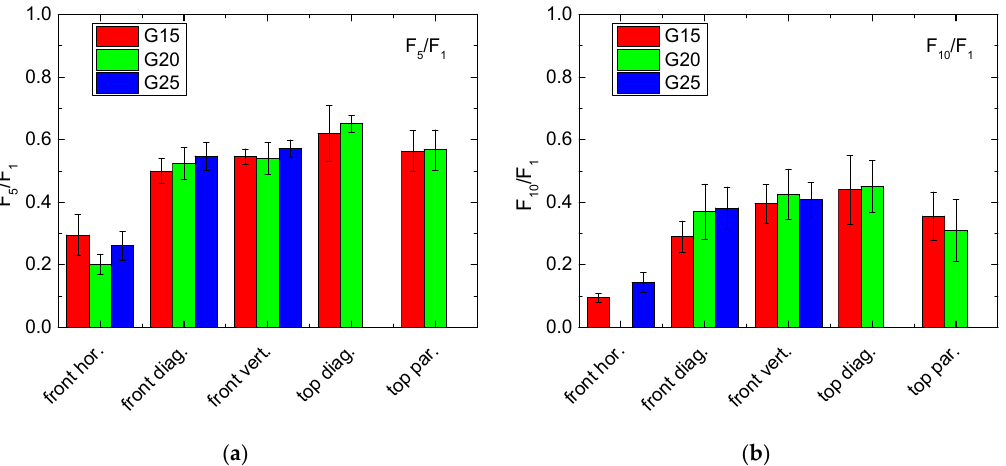
Figure 5. Force quotients of the samples under investigation, related to the force measured along an impact of 8–10 mm during the first cycle: ( a ) F 5 /F 1 ; ( b ) F 10 /F 1 .